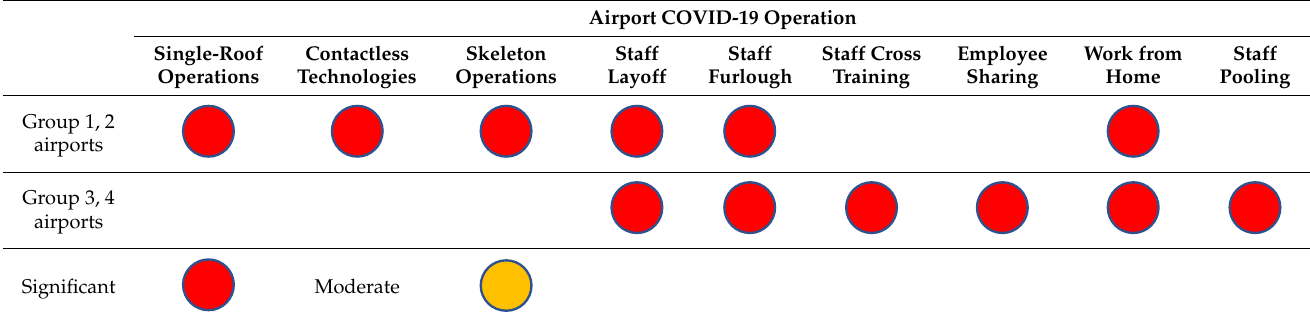
Table 1. Airport operation provisions during COVID-19.